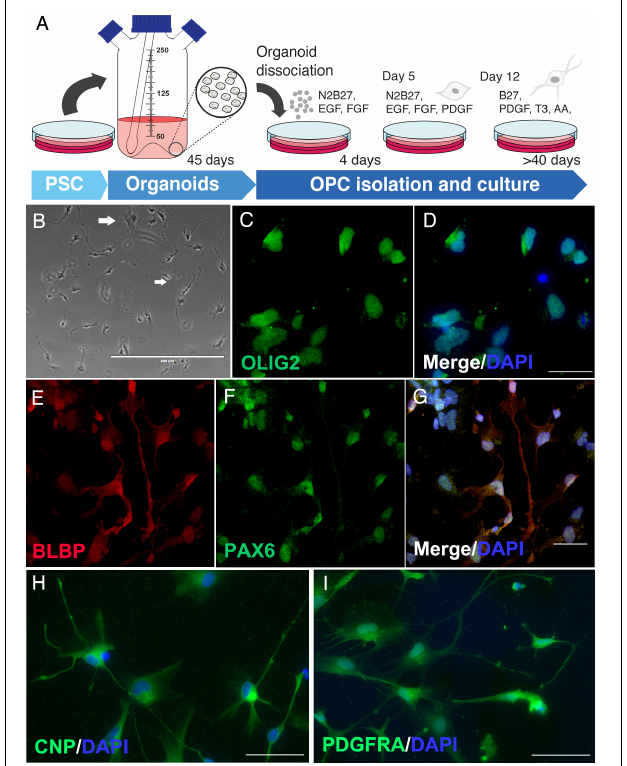
FIGURE 4 | Oligodendrocyte progenitors derived from cerebral organoids. (A) Schematic representation of OPC isolation and culture. (B) Phase contrast of immature oligodendrocytes with initial ramifications (arrows in white). OPCs were stained for (C,D) olig2, oligodendrocyte lineage transcription factor, (E–G) BLBP and PAX6 progenitor markers, (H) CNPase (CNP), enzyme of early oligodendrocyte formation and myelin precursor, and (I) PDGFRA oligodendrocyte lineage marker. Scale bars shown are (B) 400 µ m, (D,G) 30 µ m and (H,I) 50 µ